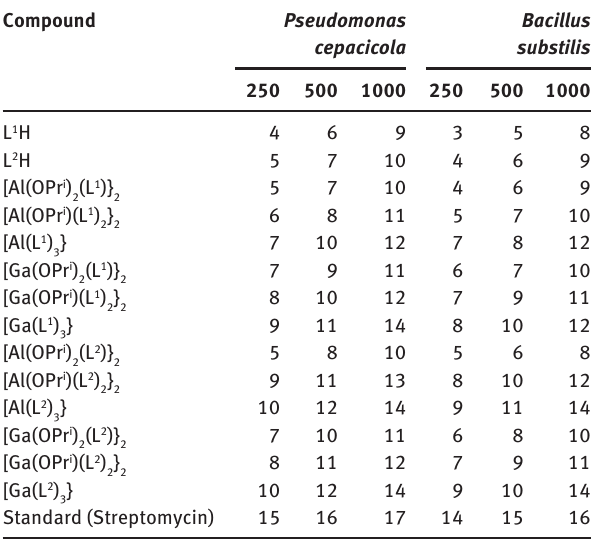
Table 6 Antibacterial screening data for the ligands and their metal complexes [diameter of inhibition zone (mm) (conc. in ppm)].